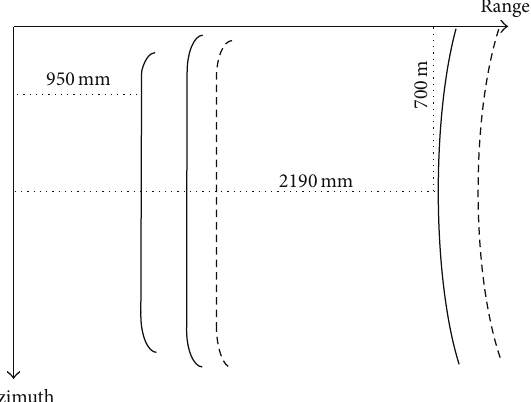
Figure 6: Expected results after an SAR measurement. Energy is spread in azimuth following a hyperbolic function. Certain elements will be shifted in range (dashed